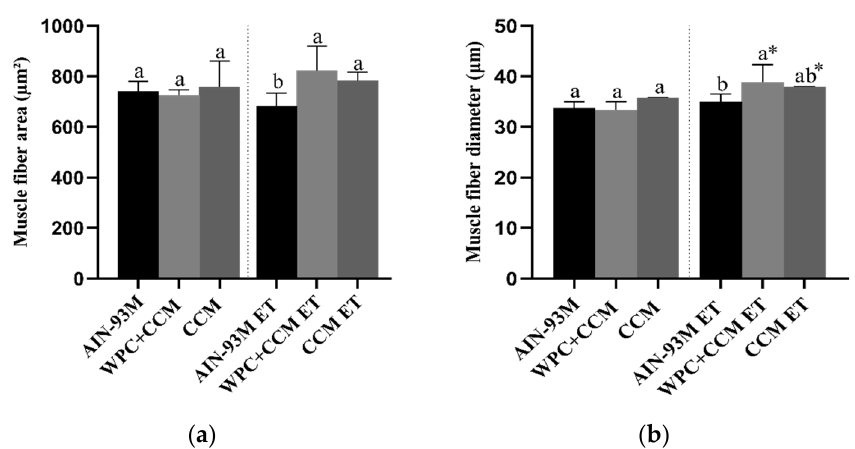
Figure 6. Histopathological analysis of muscle tissue. AIN-93M: group not submitted to ET that received a standard diet; AIN-93M ET: group submitted to the exhaustion test that received a standard diet; WPC + CCM: group not submitted to ET that received curcumin-added whey protein concentrate; WPC + CCM ET: group submitted to the exhaustion test that received curcumin-added whey protein concentrate; CCM: group not submitted to ET that received curcumin; CCM ET: group submitted to the exhaustion test that received curcumin; ET: exhaustion test. The graphs show ( a ) area of muscle fibers ( μ m²), ( b ) diameter of muscle fibers ( μ m). * indicates significant differences within the same group (not submitted to ET × submitted to ET), according to the t -test ( p < 0.05). According to ANOVA, different lowercase letters ( a , b ) indicate significant mean differences among the groups, followed by the Newman–Keuls test, at 5% probability. Same lowercase letters indicate that there was no significant mean difference among the groups. Data expressed as mean ± standard deviation.